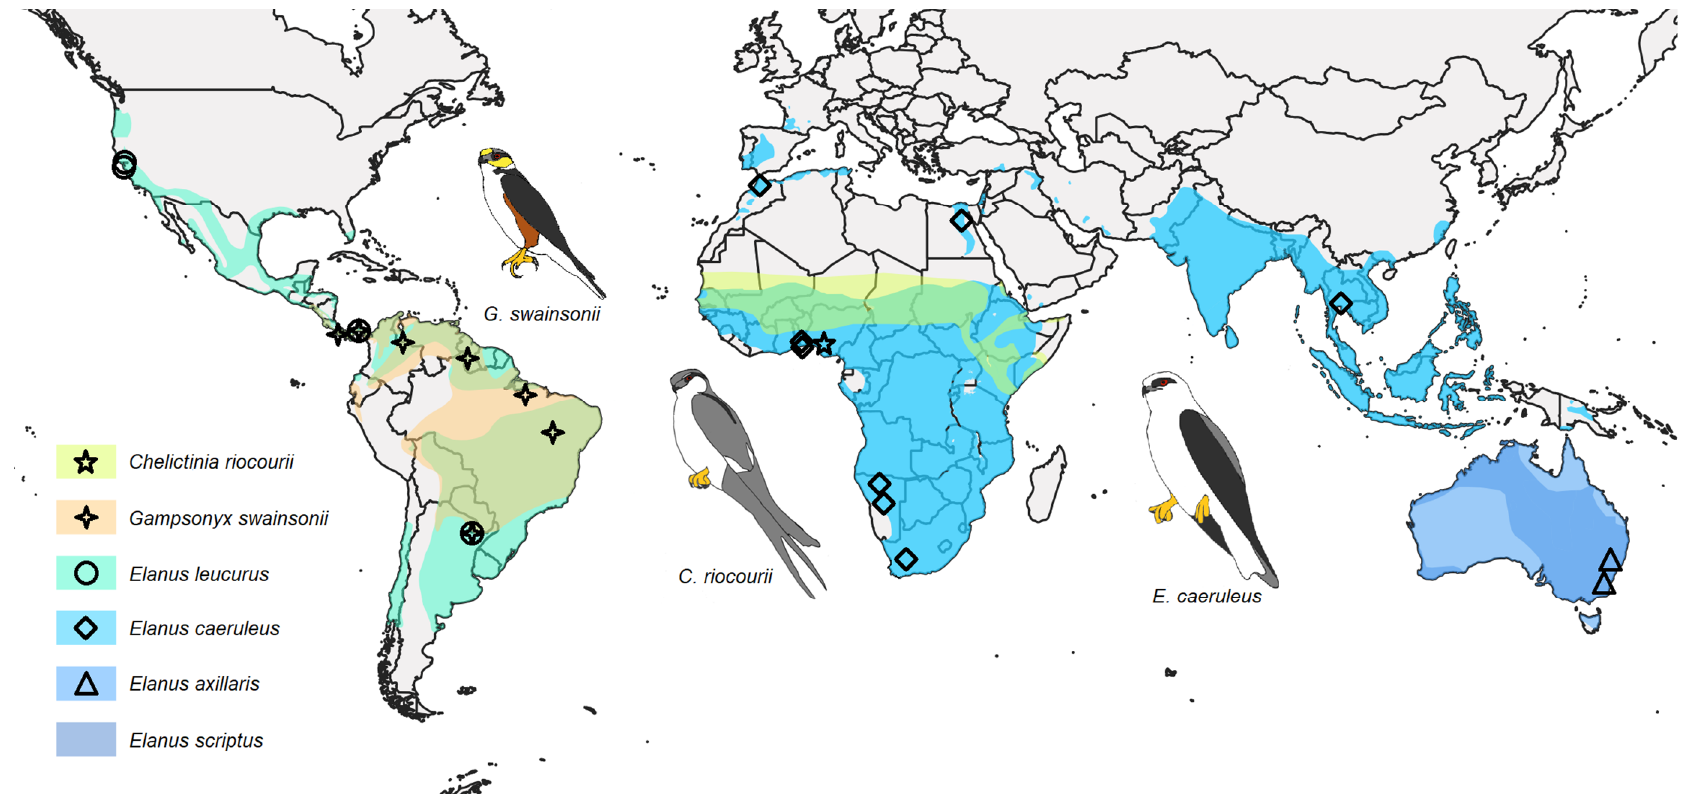
Figure 1. Sample locations (geometric symbols), range (from [10–15]), and schematic illustrations of Elanin kites genera representatives.